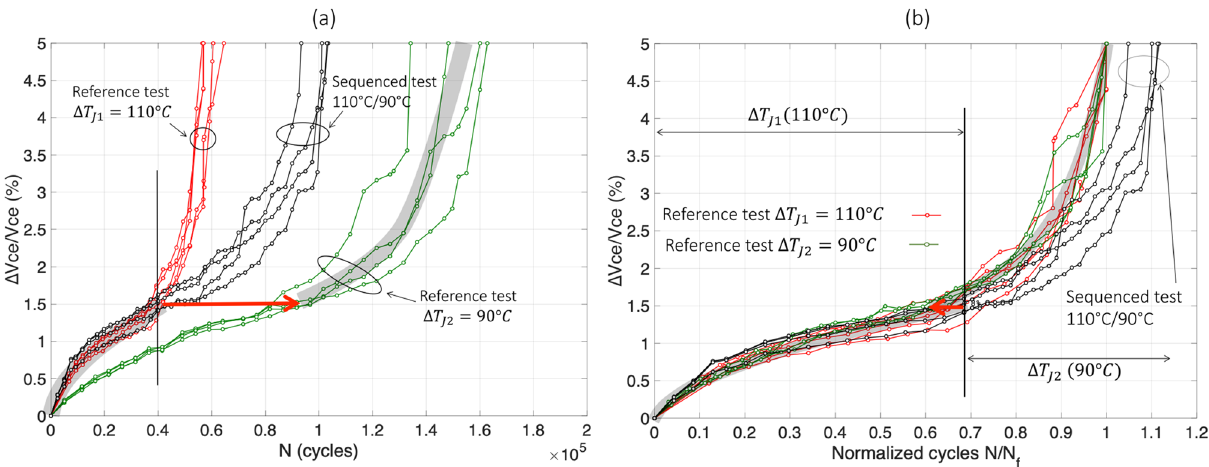
Figure 6. The sequenced test 110 °C/90 °C (test#5), normal scale in cycles ( a ) and normalized in N f ( b In other words, for test#8, if the Miner’s rule were satisfied the second part should look like the red curves (given by the trend of the thick grey line) from 1.7% in Vce. In this case, the number of normalized cycles of this ref second part would have been N 2 / N f ref 2 ≈ 0.3, i.e. from 0.5 (beginning of the thick dotted grey line) to 0.8 (end of the thick dotted grey line). For the passage from 1st stress level to the 2nd, only the amount of degradation reached counts. The deviation from the Miner’s rule is given by ∆ in the left direction (∆ < 0), see Fig. 4b. This result indicates that in this low–high stress sequence, during the second stress level, aging is faster (black curves) than in the reference test (red curves). The dispersion in the ∆ value is in the range [− 0.15; − 0.12]. The results of test#7 are reported in Fig. 5. In Fig. 5a, the sequenced curves (in black) begin with (cid:31) T j 1 = 110 °C and follow, as expected, the reference test at same (cid:31) T j (red curves). Then, when ∆ V ce / V ce reaches 1.5% increase, the second stress level ( (cid:31) T j 2 = 70 °C) is applied and the black curve increases more sharply than the correspond- ing reference test (blue curves). In Fig. 5b, the same results are presented in normalized scale for both reference tests. It can be observed that, in this high-low stress sequence, in the second stress level, i.e. after 1.5% increase, aging is also faster (black ref seq seq curves) than in the reference test (blue curves). In this case, N 1 / N f ref 1 ≈ 0.69 1 / N f ref 1 ≈ 0.69, N 2 / N f ref 2 ≈ 0.41, N ref (mean red curve, or grey trend curve, for ∆ V ce / V ce < 1.5%), and N 2 / N f ref 2 ≈ 0.55 (mean blue curve, or grey trend curve, for ∆ V ce / V ce ≥ 1.5%). The difference due to the sequencing effect is approximately: (cid:31) 110 ◦ C → 70 ◦ C ≈ − 0.14 with a dispersion rather low, in the range [− 0.15; − 0.13]. This value is quite the same as that for the reverse sequence: (cid:31) 70 ◦ C → 110 ◦ C ≈ (cid:31) 110 ◦ C → 70 ◦ C .